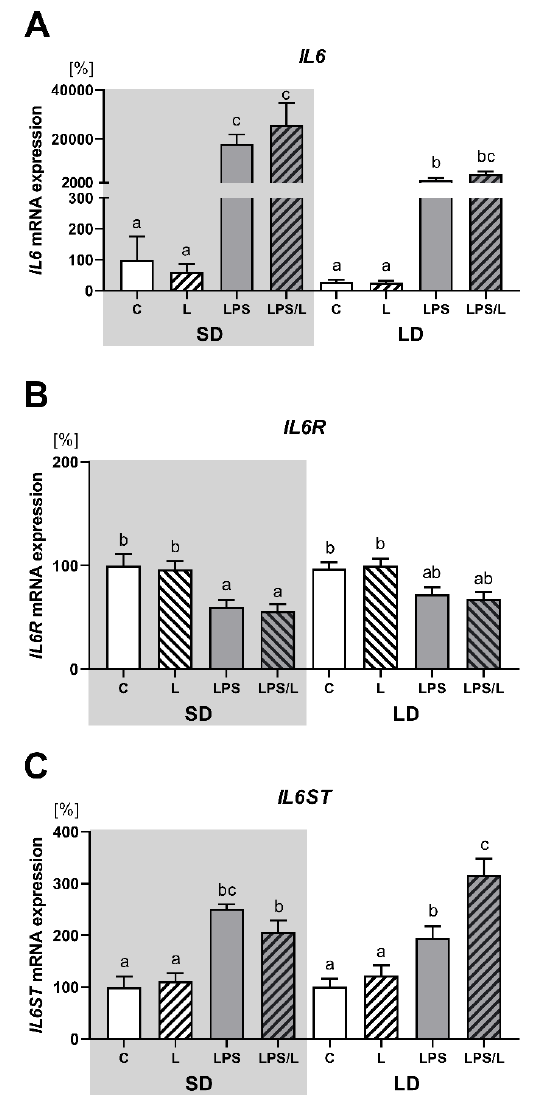
Figure 5. Mean (±SEM) relative IL6 ( A ), IL6R ( B ) and IL6ST ( C ) mRNA expression in the ovine choroid plexus of saline (C, control—white bars), saline–leptin (L, white hatched bars), LPS (grey bars) and LPS–leptin (LPS/L, grey hatched bars) treated ewes, during the short-day (SD, dark background) and the long-day (LD, light background) photoperiod. Different lowercase letters indicate significant differences between all groups at p < 0.05 (two-way ANOVA—Tukey’s post hoc test). The results are presented as percentage values (%), where the SD C group is considered as 100%.